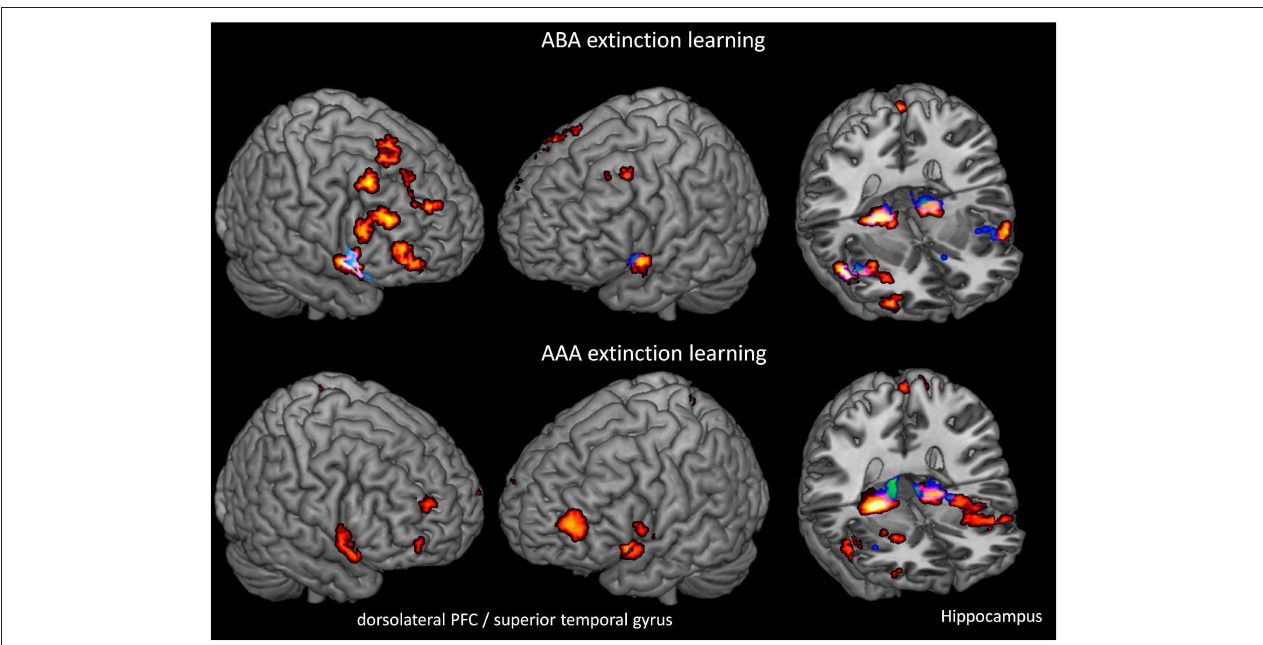
FIGURE 3 | Overlays of activation patterns in the PLAC (yellow-red) and the TIA (blue-green) group during the ABA and AAA conditions of extinction learning. The TIA group exhibits reduced activation in various regions, including dorsolateral prefrontal cortex and hippocampus in both ABA and AAA conditions. (one-sample t -tests p < 0 . 001 FWE-corrected on cluster level, minimum cluster size k = 10